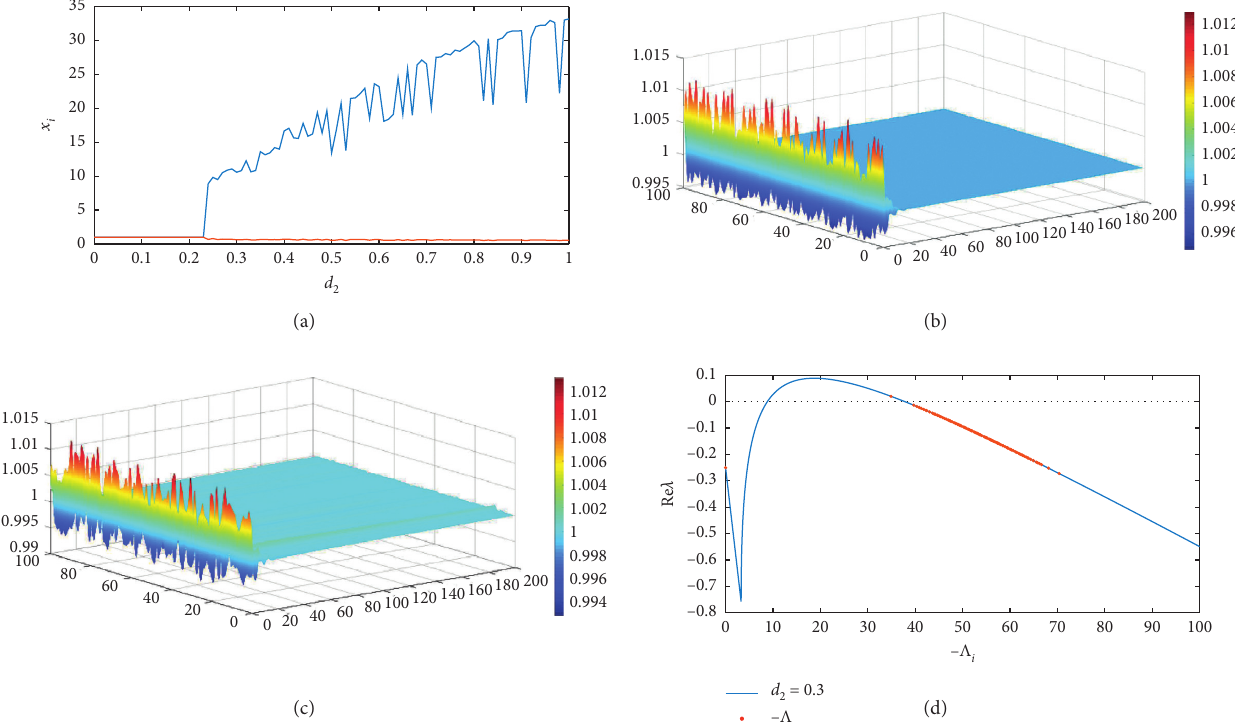
Figure 12: (a) The bifurcation diagram of d � 0 . 1. (c) Turing instability occurs when d when d 2